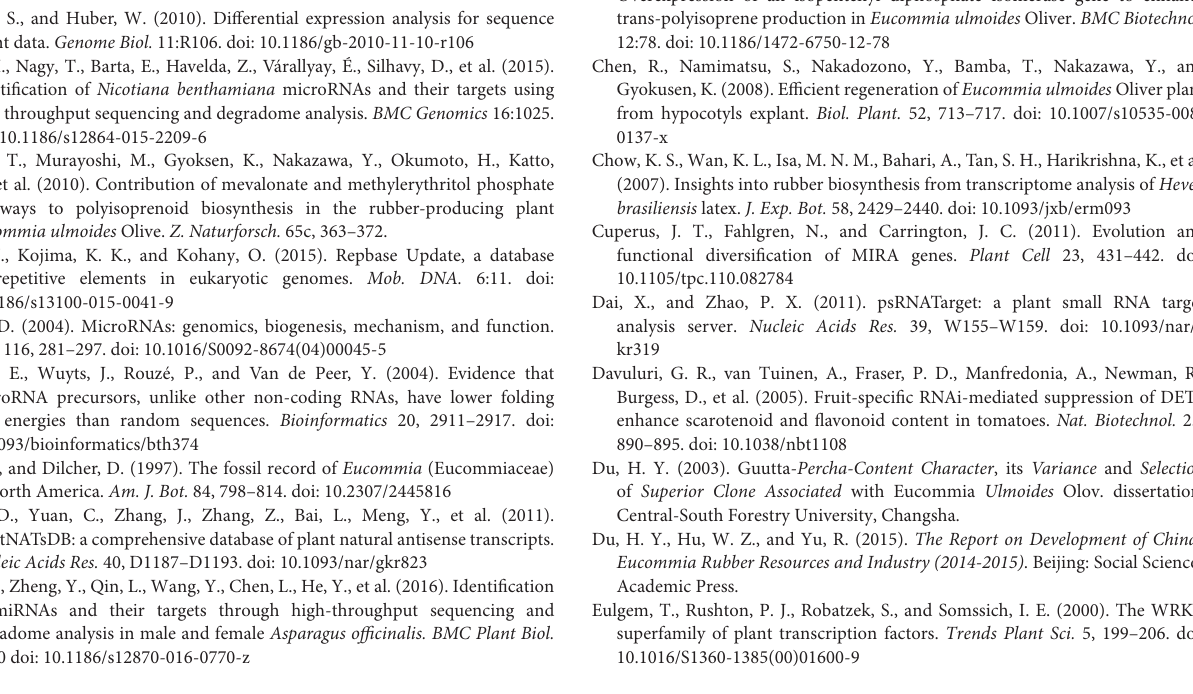
Table S1 | Primers used in qPCR analysis of miRNAs and target genes. Table S2 | Quality evaluation of sequencing data. Table S3 | Number of reads for each classified small RNA identified in Eucommia ulmoides. Table S4 | Conserved miRNAs identified from Eucommia ulmoides. Expression profiles of conserved miRNAs were estimated by transcript per million